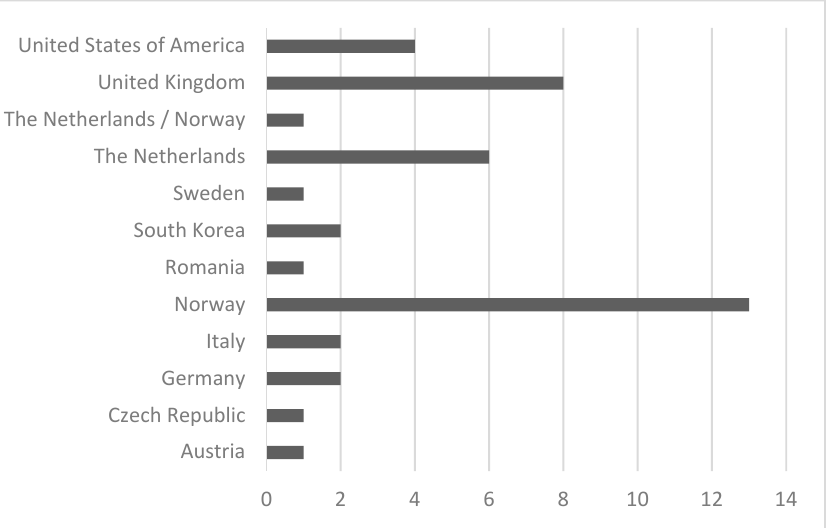
Figure 3. Distribution of records per country ( n = 42).